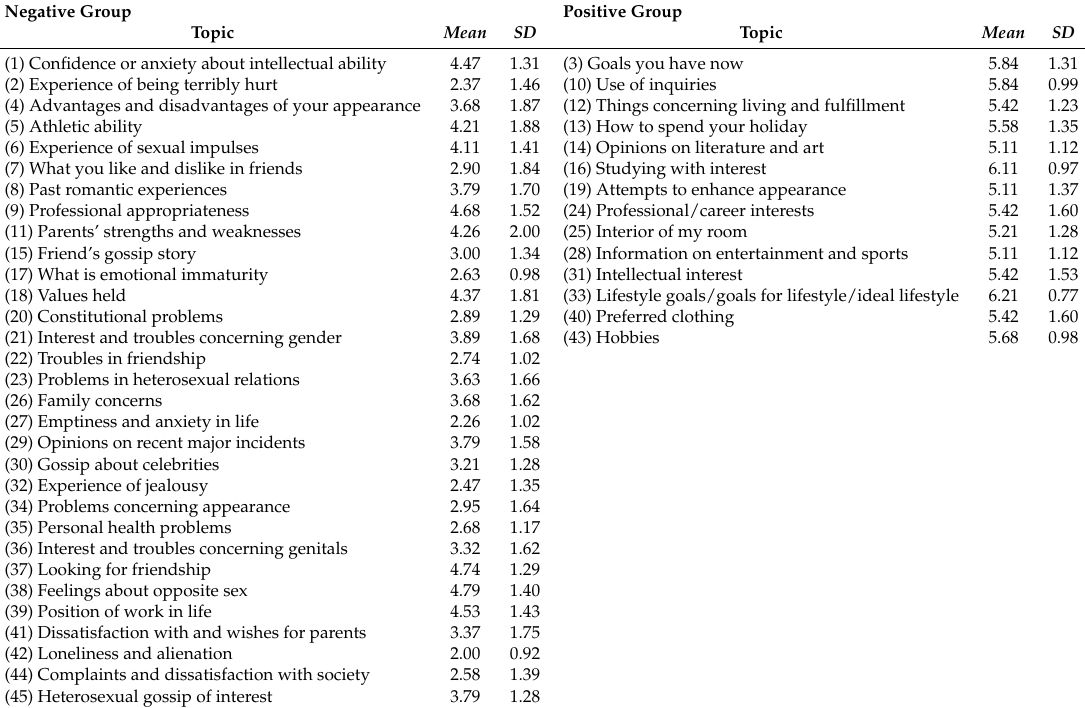
Table 2. Degree of positive/negative valence for each